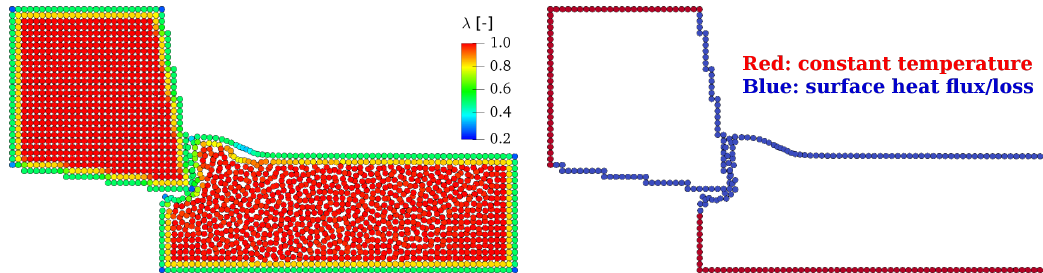
Figure 2. Illustration of the proposed approach for thermal boundary conditions. Left: introduction of the surface detection algorithm into SPH cutting models. The implementation considers the tool (rigid) and the workpiece (deformable) as two separate bodies. Right: only particles with λ < 0.75 are included and then categorized into 2 surface groups (red and blue). Thermal boundary conditions are imposed on these blue and red surface particles